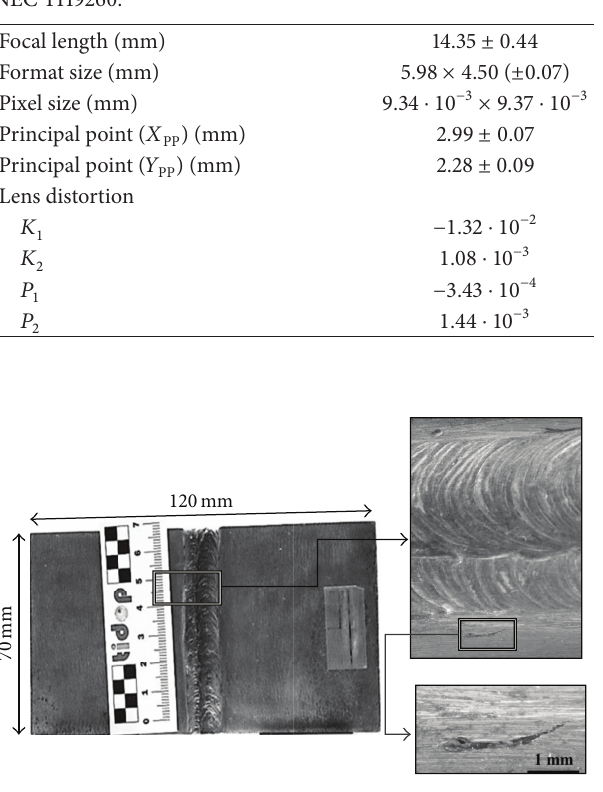
Figure 1: Low-carbon steel weld used as specimen. This presents a toe crack close to the limit of the weld